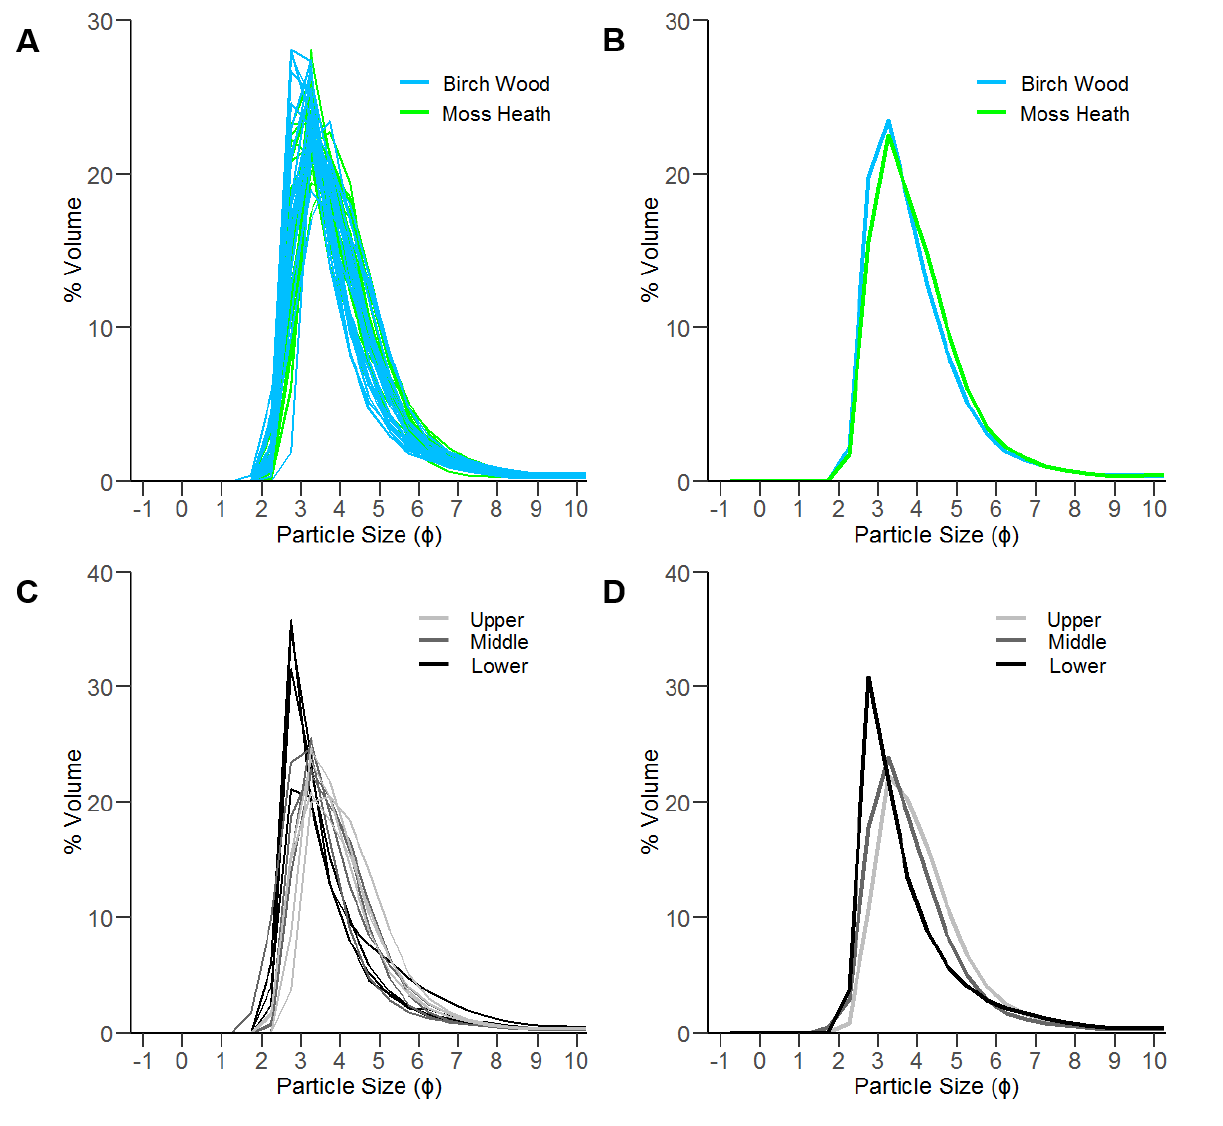
Figure 5: Grain-size distribution plots for samples of G2011 taken at Fossdalur: [A] All samples split by vegetation type (birch woodland = 25, moss heath = 25), [B] Mean grain-size distributions by vegetation type, [C] Samples taken from different portions of the layer (upper = 4, middle = 4, lower = 4), and [D] Mean grain-size distributions for each sub-sample.